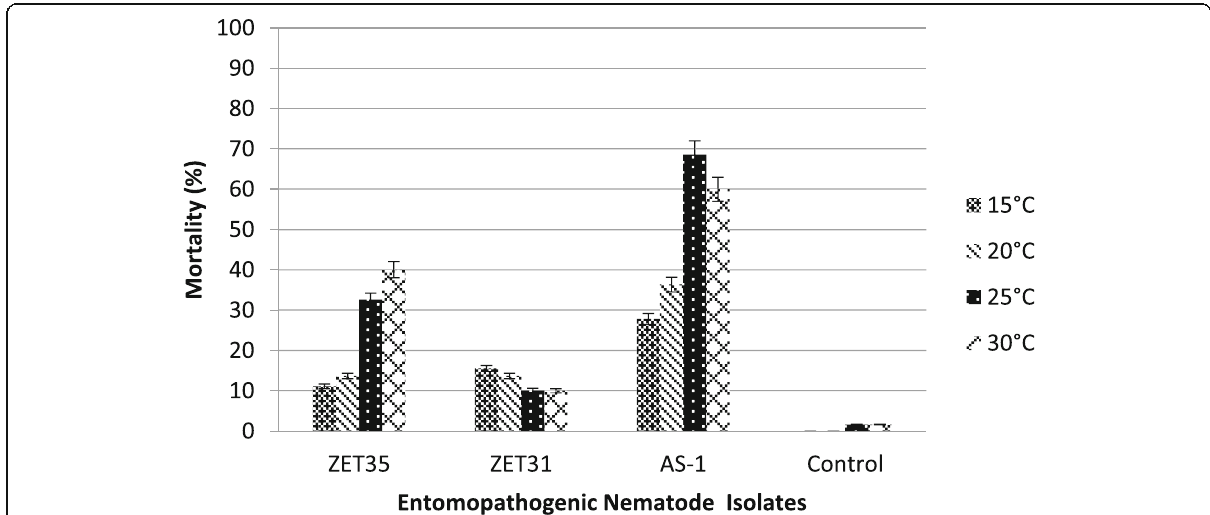
Fig. 4 Mean mortality rate of three native strains on adults of A. alni treated at a concentration of 1000 IJs/ml at four tested